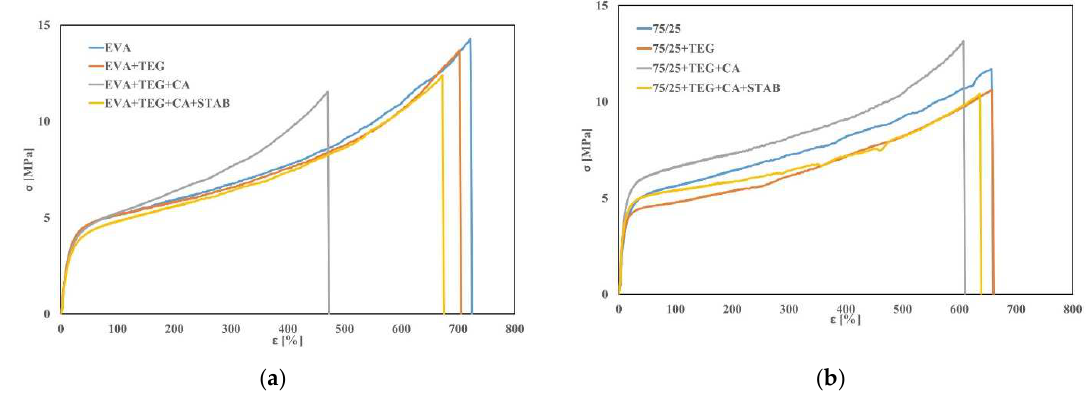
Figure 1. Stress-strain curves of the ( a ) EVA and ( b ) EVA/PO = 75/25 wt.% samples with and without an adhesion promoter (TEG), a crosslinking agent (CA) and stabilizers (STAB).